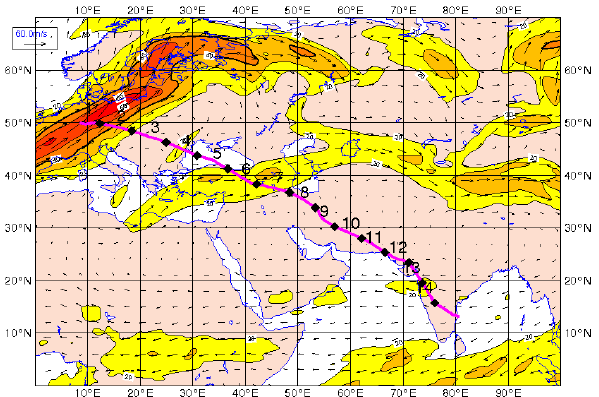
Fig. 3. Wind speed at 250hPa on August 13th 2008 for a CARIBIC flight from Germany to India. Contours and coloring are in steps of 10m/s for wind speeds between 20m/s and 70m/s. The CARIBIC flight path is indicated by the solid line, markers show the positions where air samples were collected.